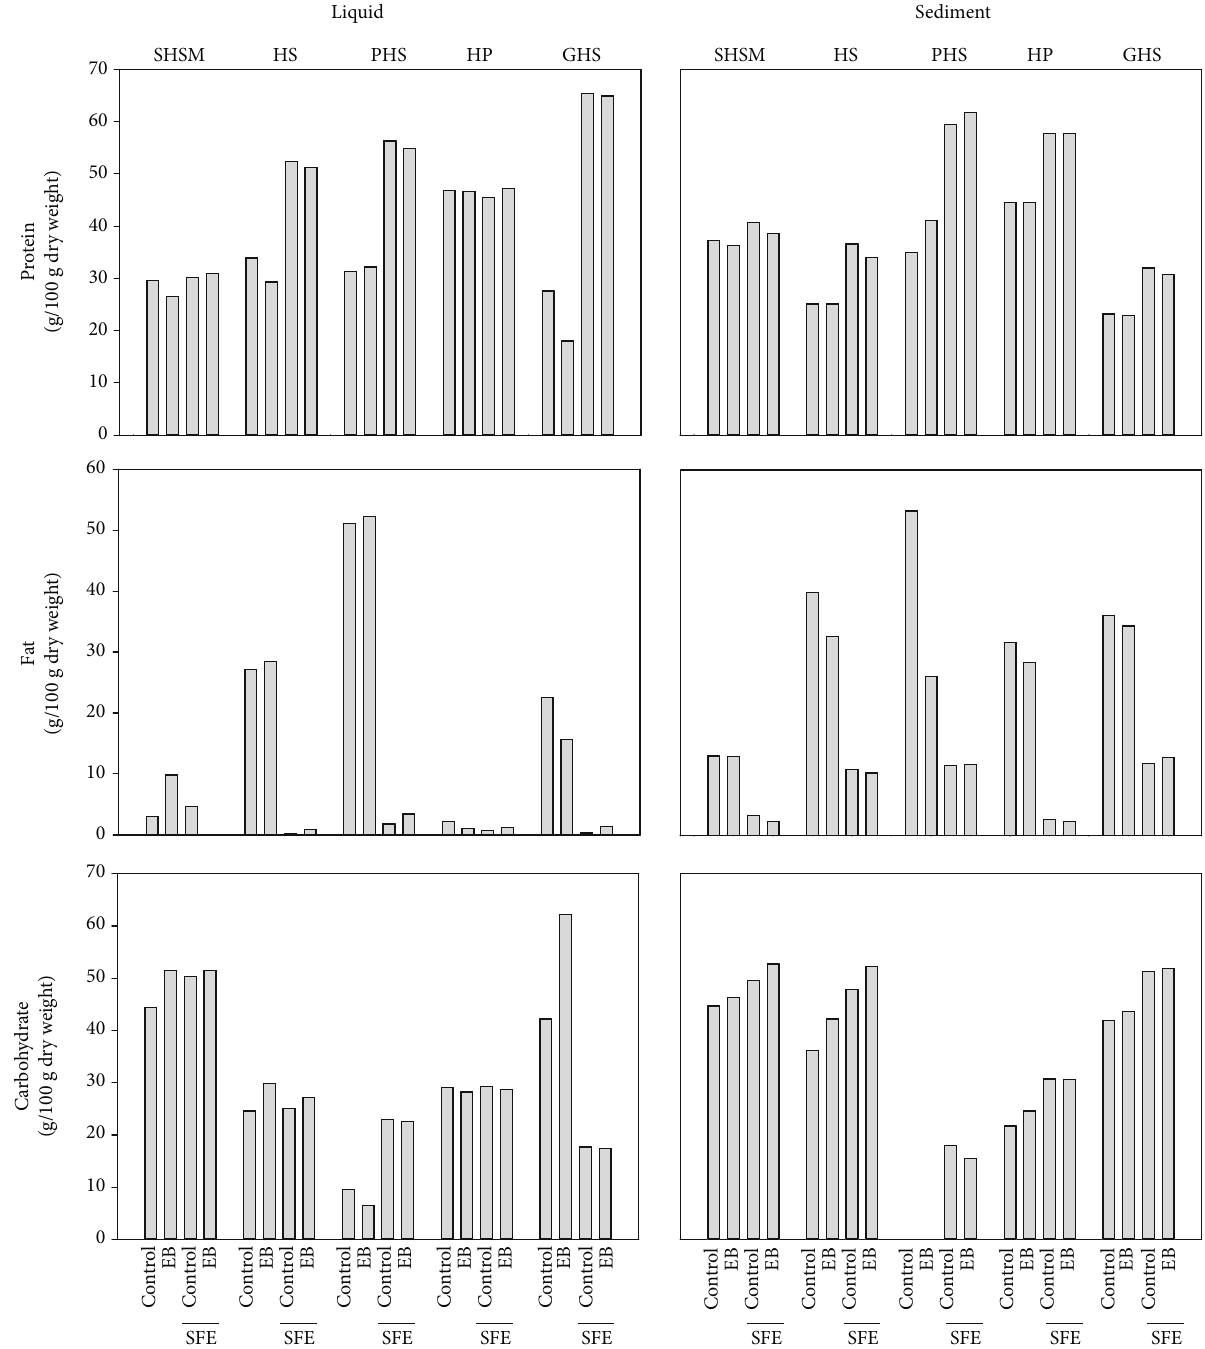
Figure 2: Basic composition of the raw materials before and after oil removal and enzyme treatment. Protein, fat, and carbohydrates were measured from hempseed meal after oil recovery (SHSM), hempseed (HS), peeled hempseeds (PHS), hempseed protein (HP), and germinated hempseeds (GHS) before and after an enzyme blend with alcohol CGE (EB) hydrolysis and oil removal (SFE). Measurements were done from liquid and sediment fractions of the samples. Values were calculated against dry